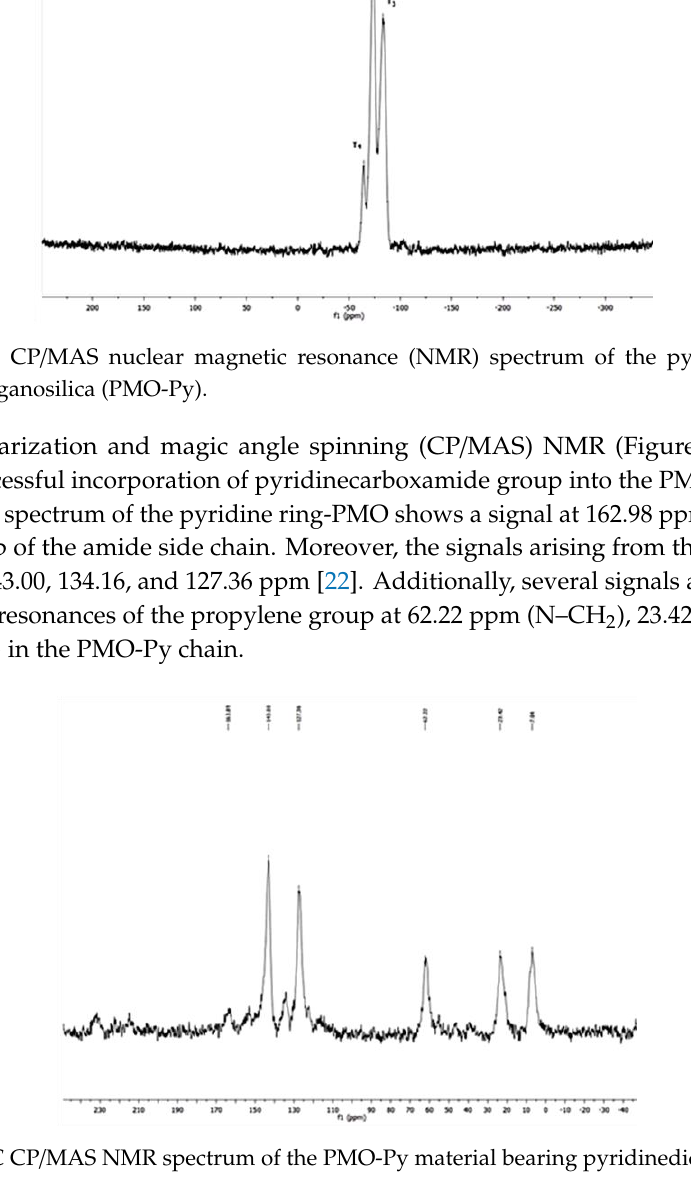
Figure 3. 13 C CP/MAS NMR spectrum of the PMO-Py material bearing pyridinedicarboxamide. Figure 3. 13 C CP / MAS NMR spectrum of the PMO-Py material bearing